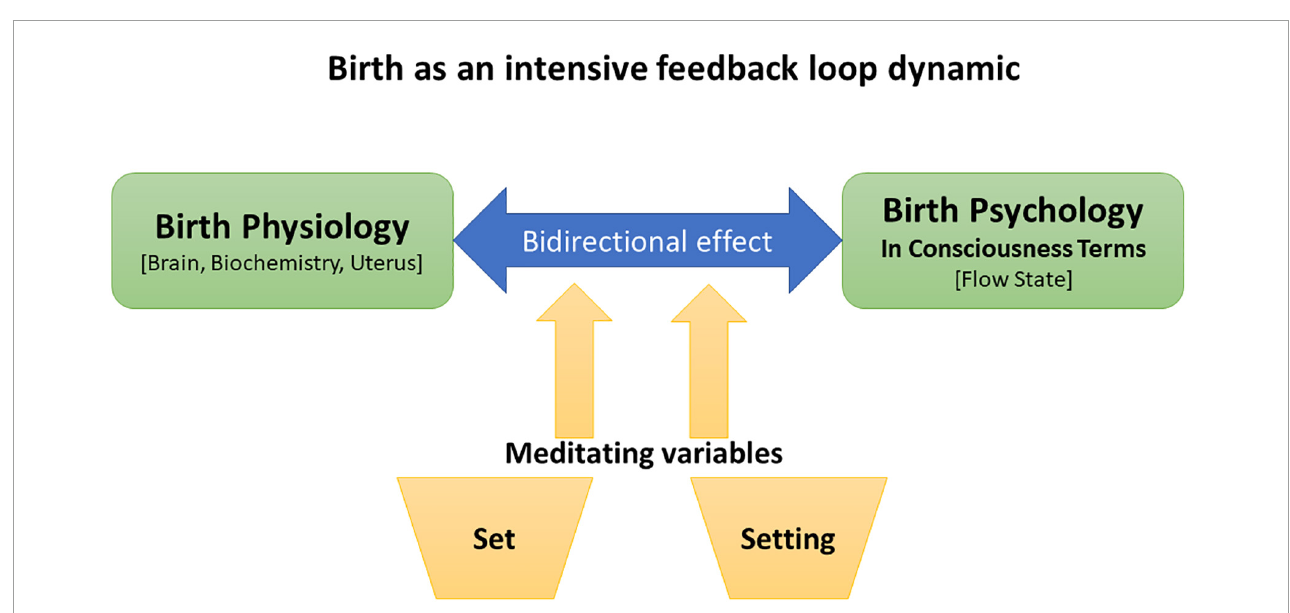
FIGURE5 The model of physiological birth in terms of set and